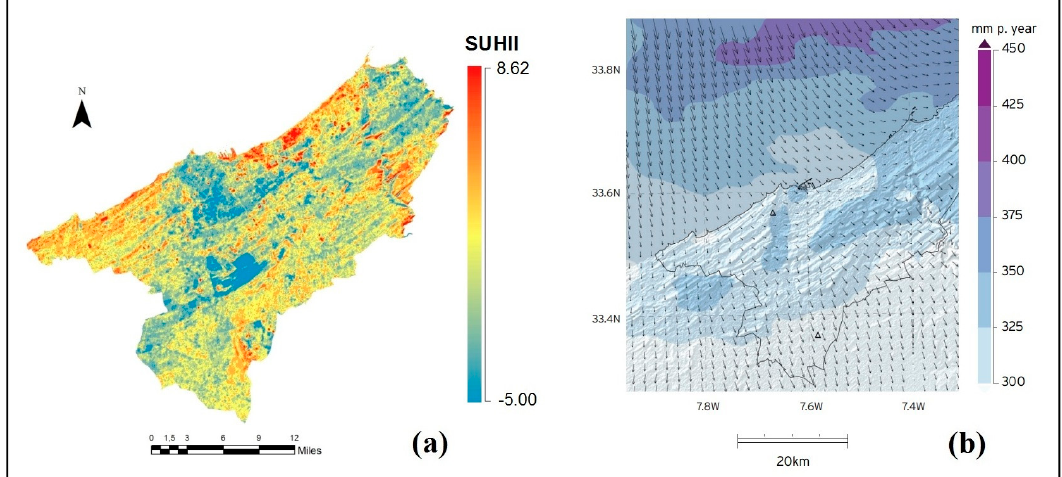
Figure 17. ( a ) Spatial distribution of SUHII in the 6 January 2016 evaluated from Landsat 8; and ( b ) mean annual of precipitation in the Casablanca region extracted from the domains of the NwAR (source: Urban Agriculture for Growing City Regions [50]).